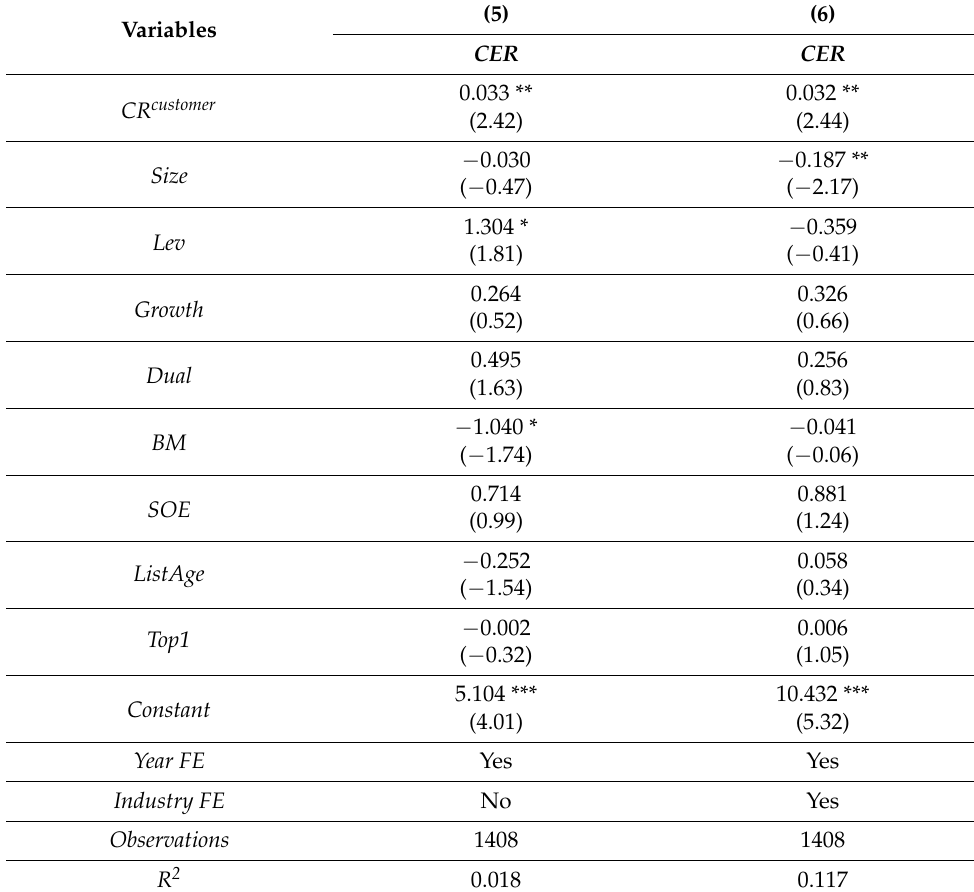
Table 5. Regressionofsupplychainpowerontheenvironmentalresponsibilityofupstream